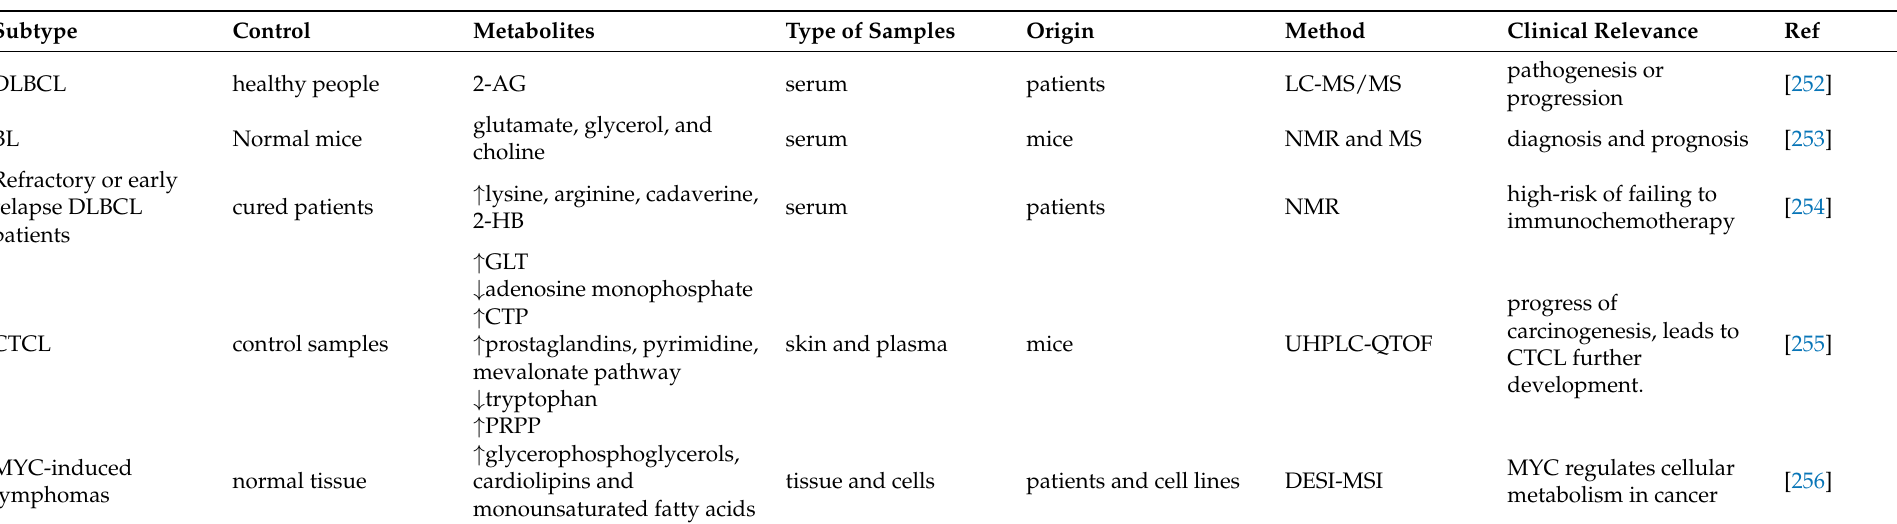
Table 4. Potential metabolic biomarkers in